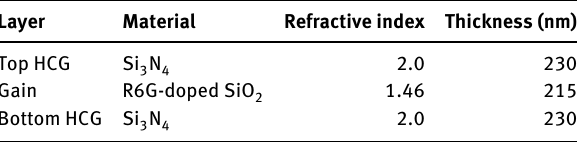
Table 1: Material